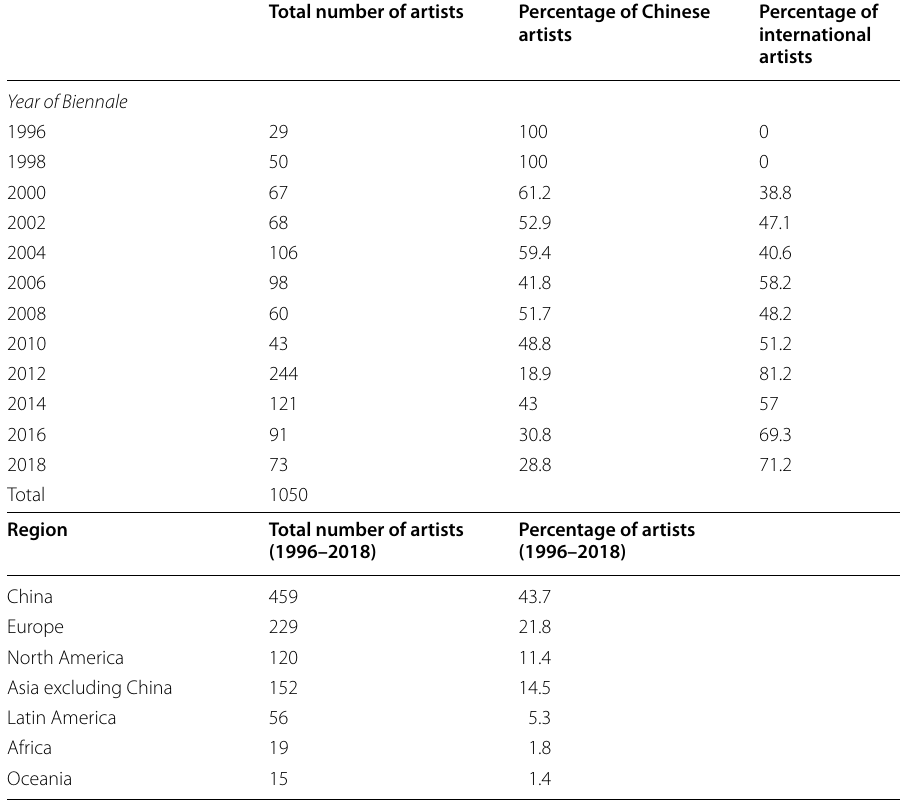
Table 1 Descriptive statistics for the artists of the Shanghai Biennale from 1996 to